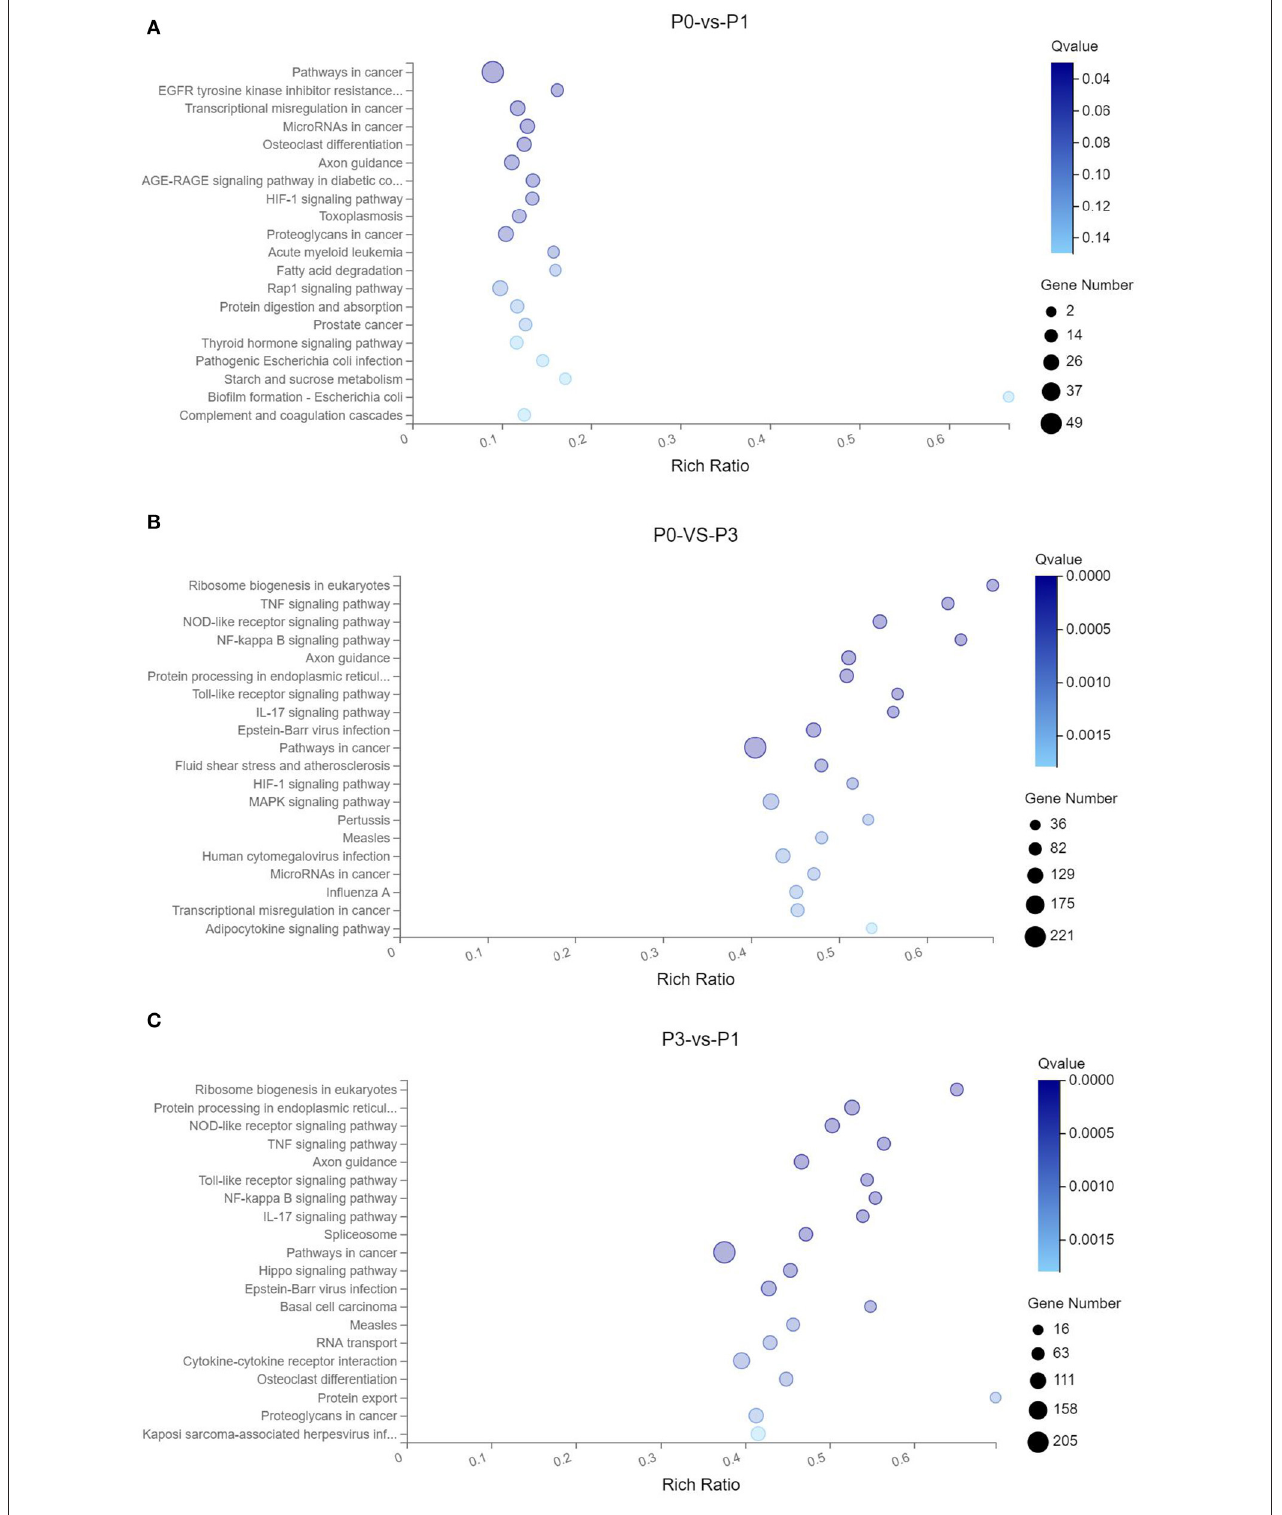
FIGURE 3 | KEGG pathway enrichment analysis of the DE mRNAs with the 20 highest rich ratios in the three comparison groups (A) P0-vs.-P1, (B) P0-vs.-P3, and (C) P3-vs.-P1. The abscissa showed the rich ratio and the ordinates showed the detailed terms. The size of dots indicates the number of enriched genes, and the color of dots indicates the degree of enrichment. Higher rich ratio correlate with lower Q-values, indicating that the enrichment of DE genes in a given pathway is significant.